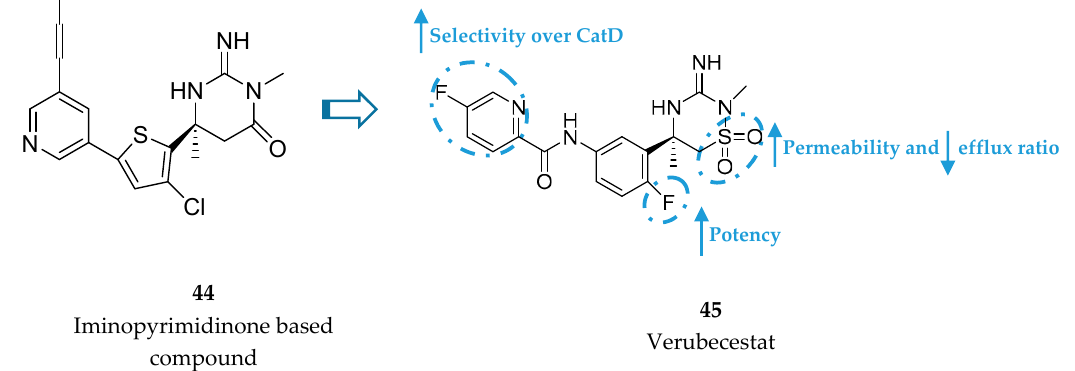
Figure 37. Drug development and SAR of verubecestat ( 45 ).